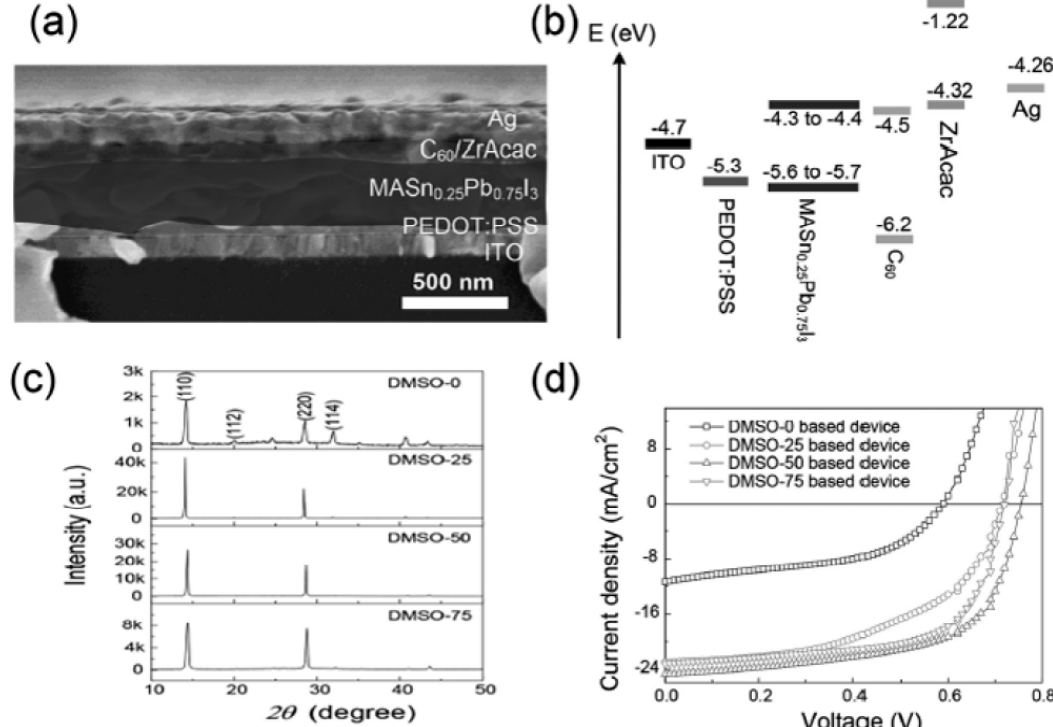
Fig. 11. Device structure and performances: (a) Cross-sectional SEM image (ITO/PEDOT: PSS/ MASn Pb I /PC BM:C /ZrAcac/Ag) (b) energy-level diagram of Sn-Pb alloyed PVSCs. (c) XRD pat- 0.25 0.75 3 61 60 terns of Sn-Pb alloyed perovskite films produced from different DMSO/DMF ratios based precursors DMSO- 0, DMSO-25, DMSO-50 and DMSO-75 and (d) Typical current density as a function of voltage curves ( J–V ), reprinted with permission from H.L. Zhu, J. Xiao, J. Mao, H. Zhang, Y. Zhao and W.C.H. Choy // Adv. Funct. Mater. 1 (2017) 1605469. © 2017 WILEY-VCH Verlag GmbH & Co. KGaA, Weinheim.